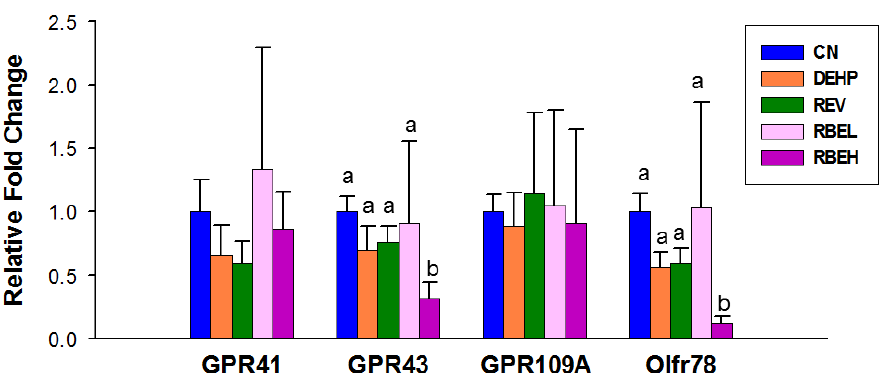
Figure 5. Effect of di-2-ethylhexylphthalate (DEHP), resveratrol (REV), and resveratrol butyrate ester (RBE) on short chain fatty acid (SCFA) receptors in 12-week-old male offspring kidneys, including G protein-coupled receptor 41 (GPR41), GPR43, GPR109A, and olfactory receptor 78 (Oflr78). The letters a and b indicate the differences between the groups ( p < 0.05, one-way ANOVA with post hoc Tukey’s test); CN= control; N = 8/group.